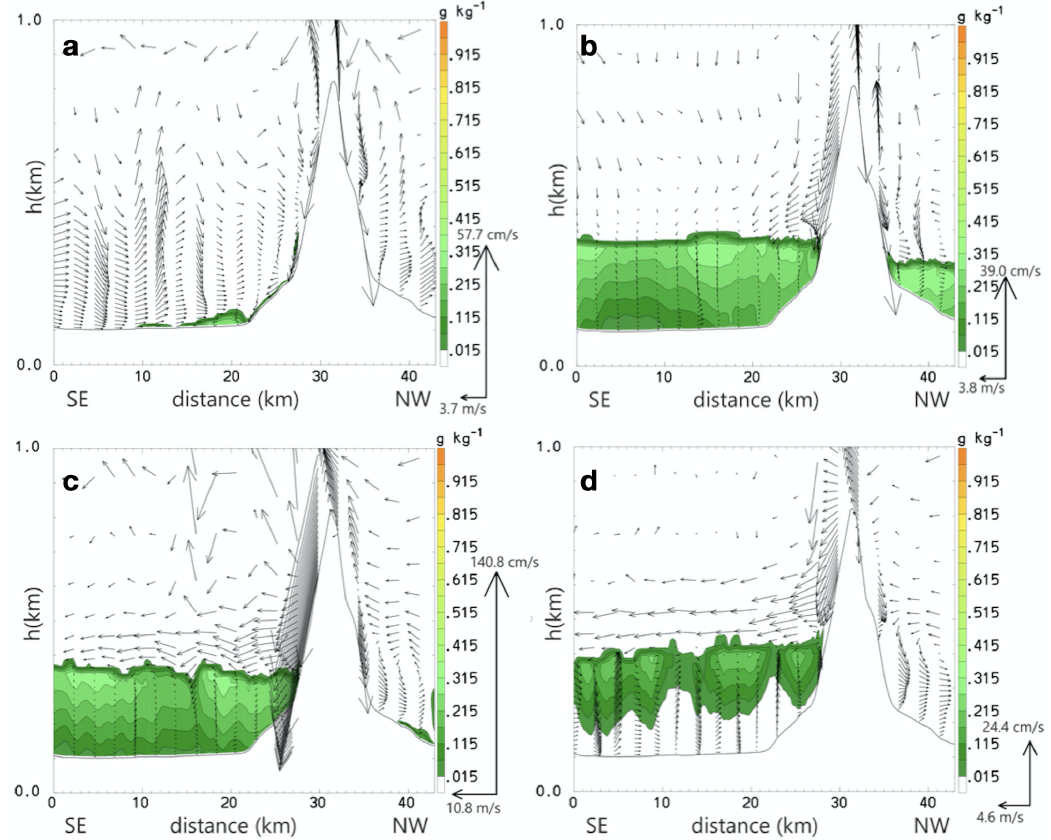
Figure 5. Deep fog layer on 28–29 January 2018: vertical cross-sections perpendicular to the Medvednica slope towards Zagreb Airport of wind vectors and cloud water at ( a ) 18 UTC, ( b ) 00 UTC, ( c ) 06 UTC, and ( d ) 11